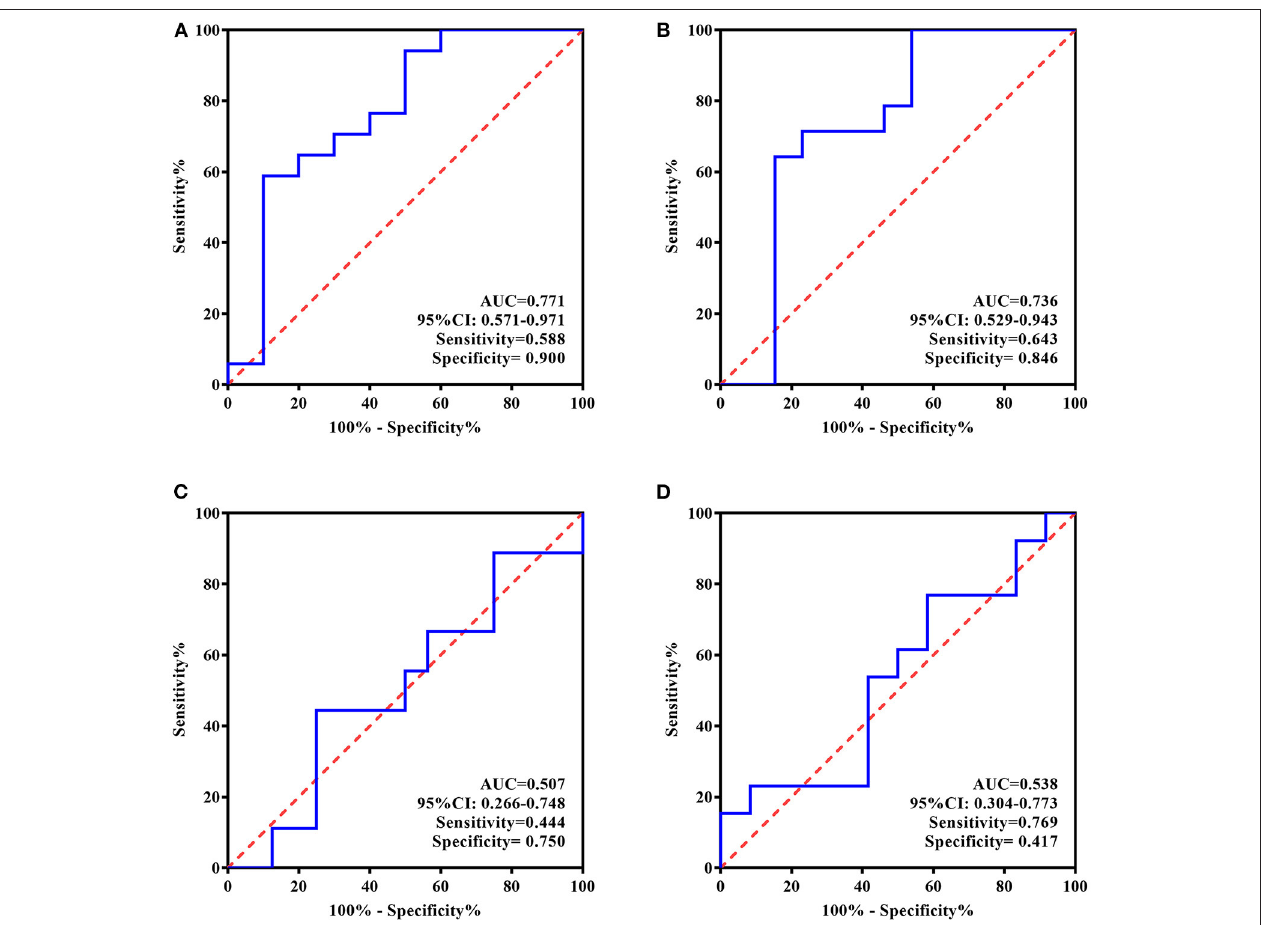
FIGURE 5 | ROC Curve for the evaluating and predicting performance of ATIII in the standard group. (A) ROC curve of ATIII at baseline for predicting the response to 5-day treatment; (B) ROC curve of ATIII at baseline for predicting the remission in 4 weeks following the treatment termination; (C) ROC curve of ATIII at day 5 for estimating the response to 5-day treatment; (D) ROC curve of ATIII at day 5 for predicting the remission in 4 weeks following the treatment termination. ROC curve, receiver operating characteristic curve; AUC, area under the curve; CI, confidence